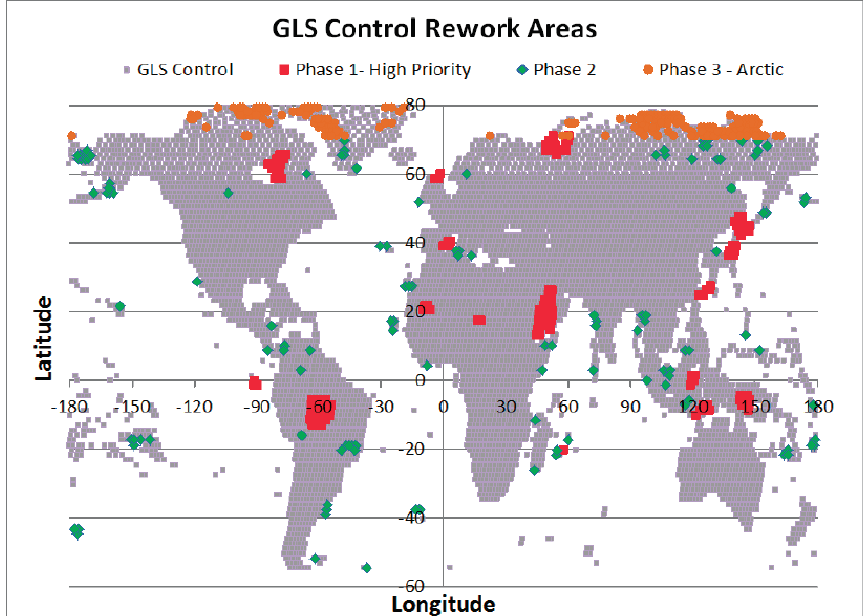
Figure 12. Landsat 8 ground control improvement sites. The 15 highest priority areas are shown in red, second priority areas are shown in green, and high latitude areas are shown in